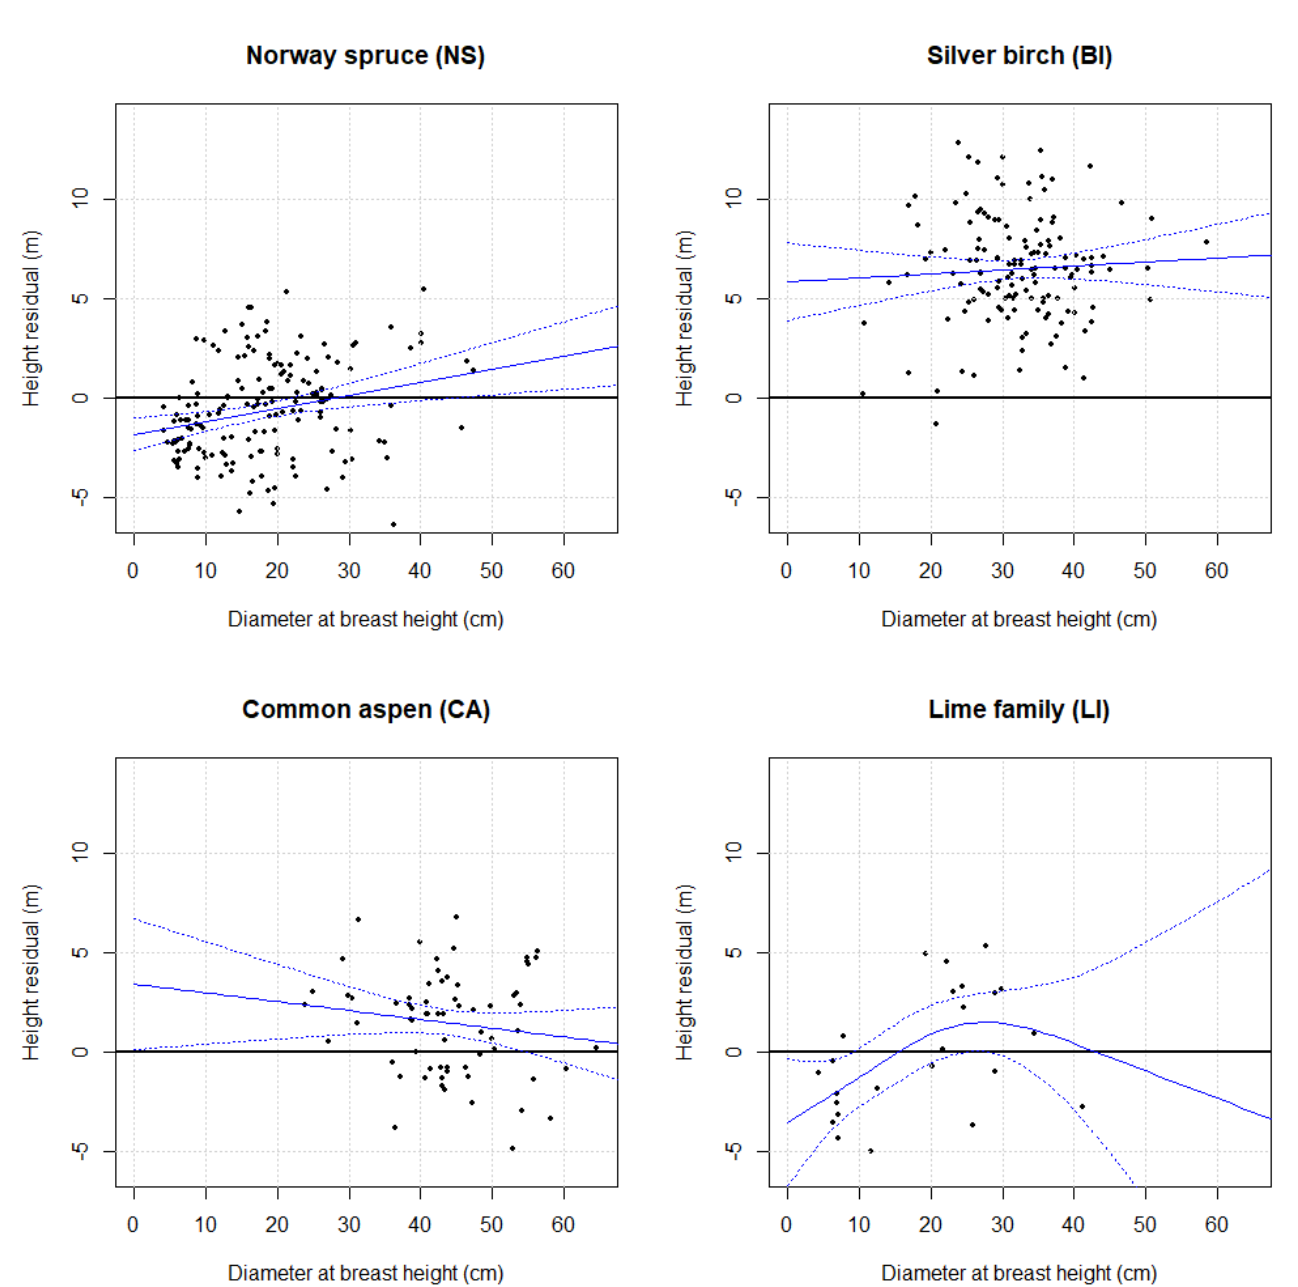
Figure 5. Comparison of H-D relationship modeled based on Järvselja old-growth forest and measured in managed Laeva municipality forests growing on fresh boreo-nemoral forest type. Residuals of the H-D relationship and empirical smoother with 95% confidence interval are presented.